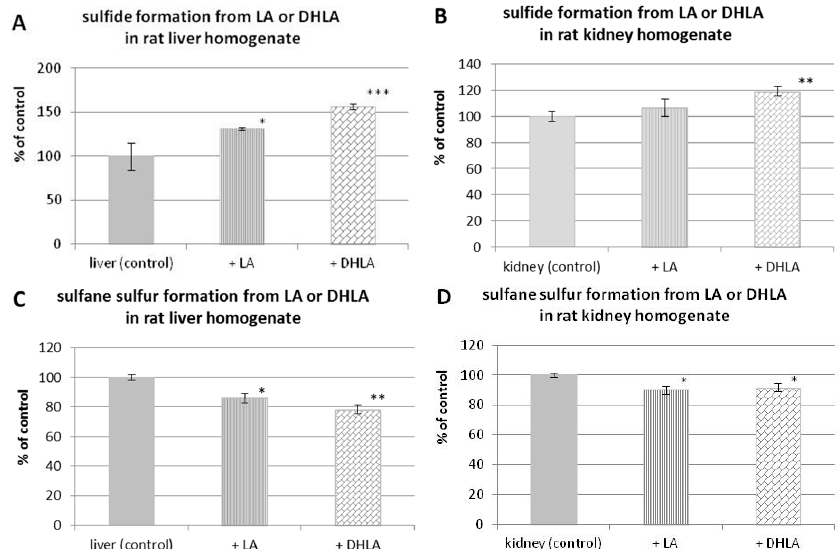
Figure 5. Level of hydrogen sulfide ( A , B ) and sulfane sulfur ( C , D ) formed in vitro enzymatically in the presence of rat liver or kidney homogenate from fresh LA or dihydrolipoic acid (DHLA) protected from light compared to endogenous hydrogen sulfide and sulfane sulfur level in homogenates (control). The results are presented as the means ± SD. Statistical significance compared to the control (* p < 0.05; ** p < 0.01; *** p <0.001).